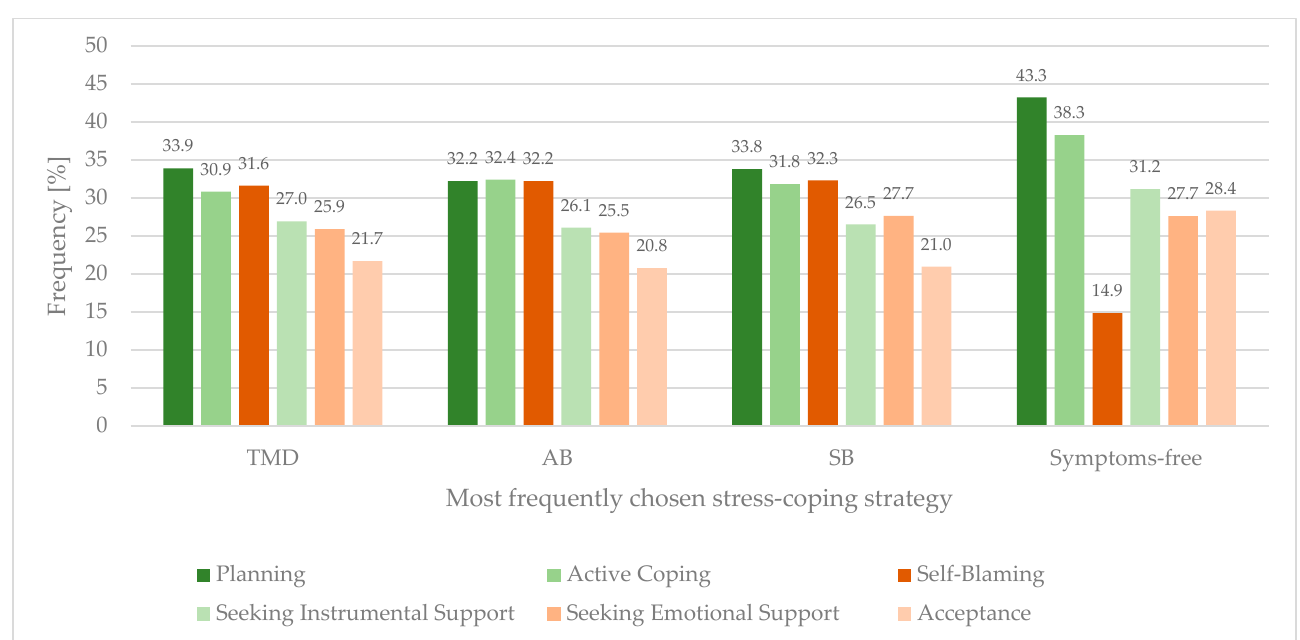
Figure 2. Frequency (percentage of subjects) of choosing most chosen coping strategies among sub- jects presenting TMD symptoms, possible AB and SB, and symptom-free.